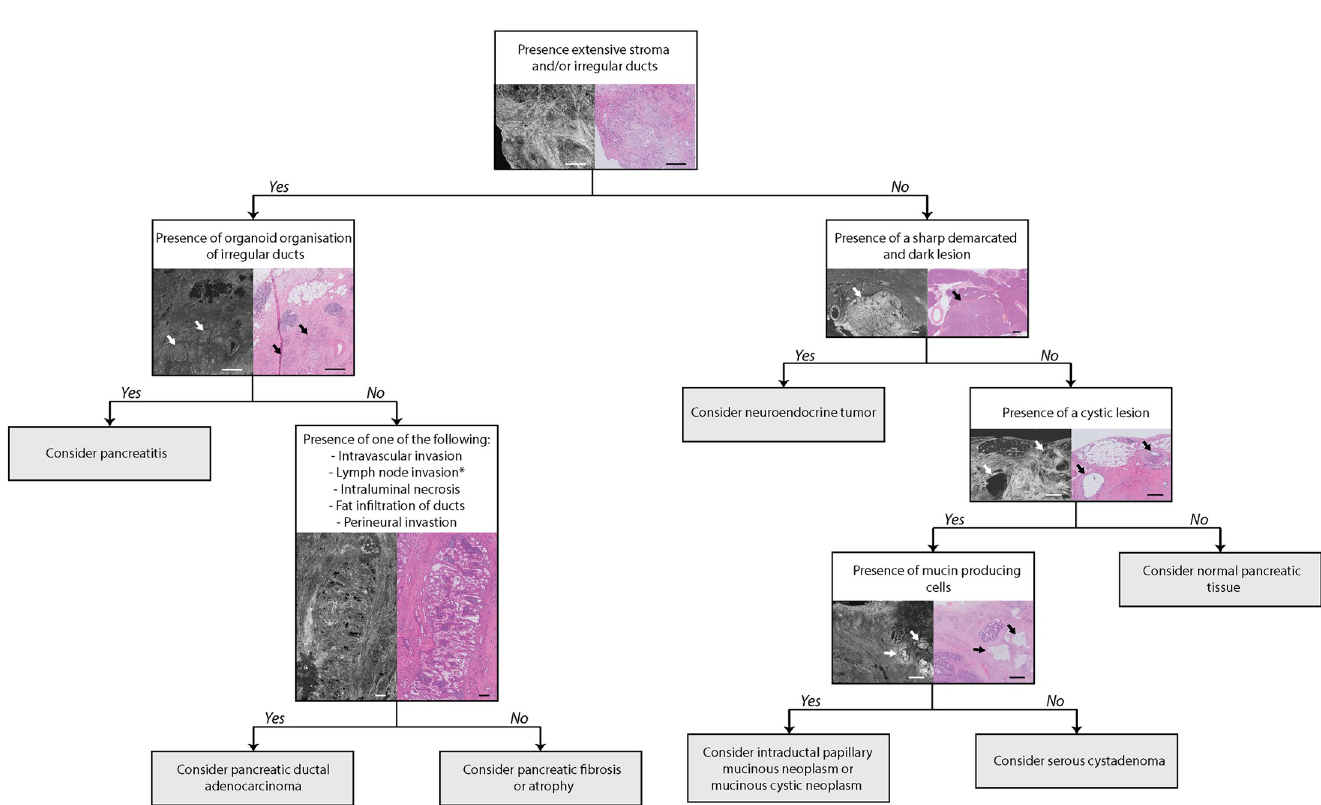
Fig 6. Proposed decision tree to evaluate pancreatic FF-OCT images. Scalebarsare all 500 μ m. * The FF-OCT image and correspondinghistology image only depict lymph node invasion.